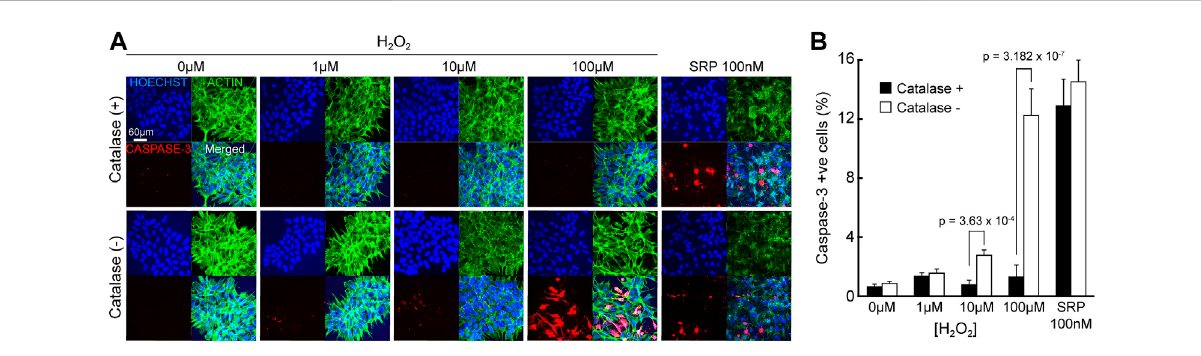
FIGURE 7 eLOSS does not induce pH or apoptotic stress. (A) Confocal images of hNPCs after 4-h culture in culture medium containing H 2 O 2 with or without catalase: Nucleus (blue), Caspase-3 (red), Actin (green). (B) Quantitative analysis of percentage of cells with caspase-3 activation under different H 2 O 2 concentrations. SRP: staurosporine.